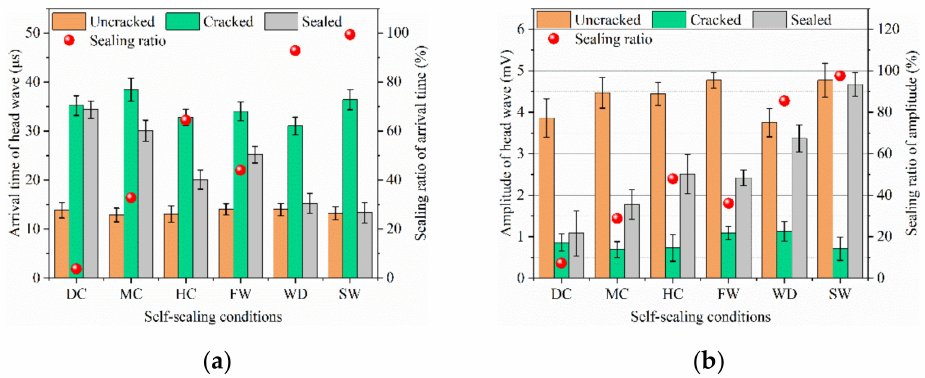
Figure 9. Self-sealing ratios based on the arrival time ( a ) and amplitude ( b ) of head waves. The results of the self-sealing ratios are shown in Figure 9. The E t and E a of the samples experiencing the static water were close to 100%. The best self-sealing of mortar depended on the continuous hydration of cement particles and the carbonization of hy- dration products, which benefit from the static liquid water. For the samples cured in the air with 30% RH, the E t and E a were below 10%. Therefore, the self-sealing of mortar is difficult to improve in dry air. Although the liquid water is indispensable for the good self-sealing of mortar, the E t and E a of the samples cured in the flowing water are lower than that of the samples cured in the air with 95% RH. This is because the Ca 2+ is taken away by the flowing water, which thereby adversely affects the formation of CaCO 3